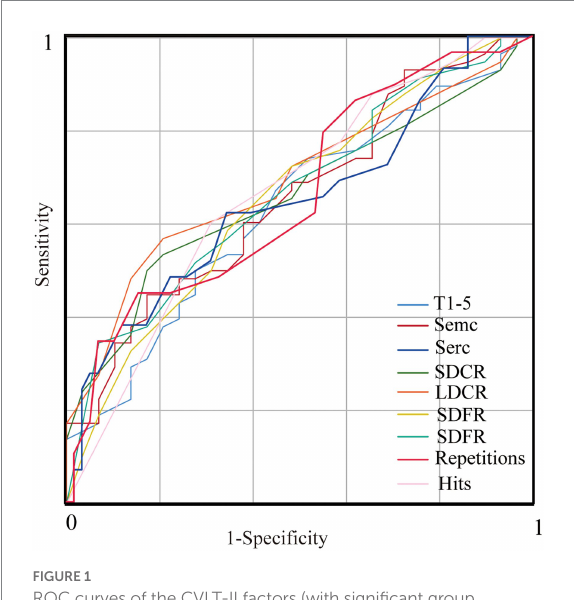
TABLE 7 Equivalent scores for the adjusted CVLT-II scores.